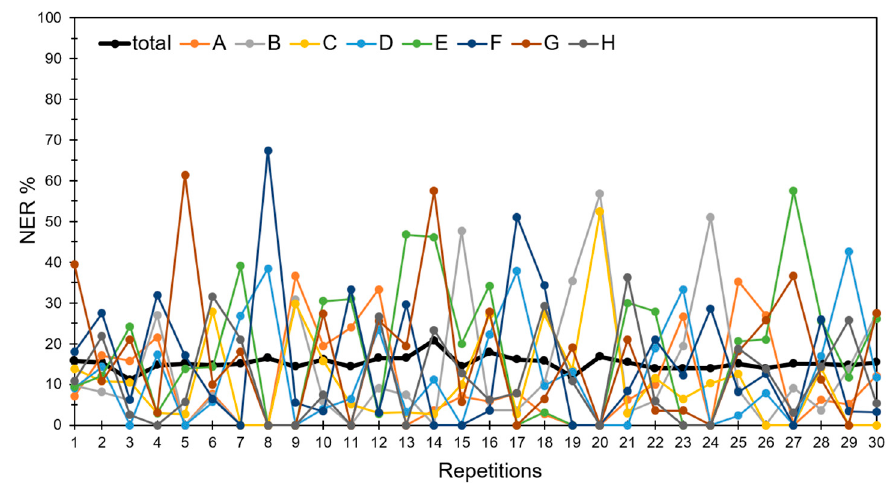
Figure A1. Tubers of some of the investigated potato accessions.